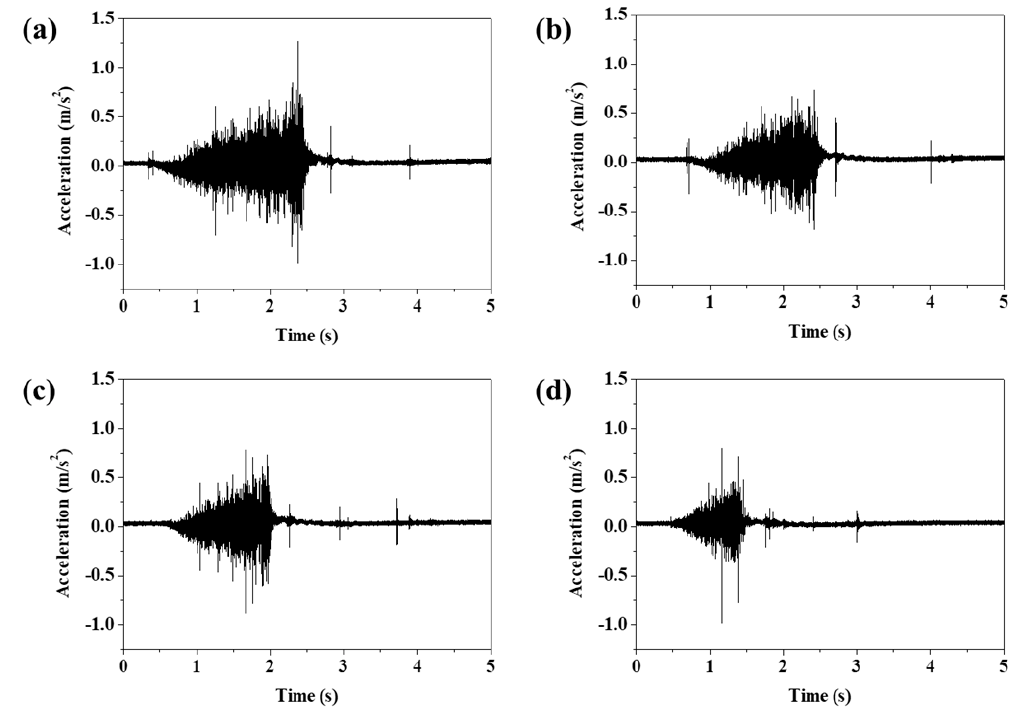
Figure 1. Vibration responses of the nut-runner during bolt tightening for clamping force of ( a ) 47 kN, ( b ) 37 kN, ( c ) 27 kN and ( d ) 17 kN.